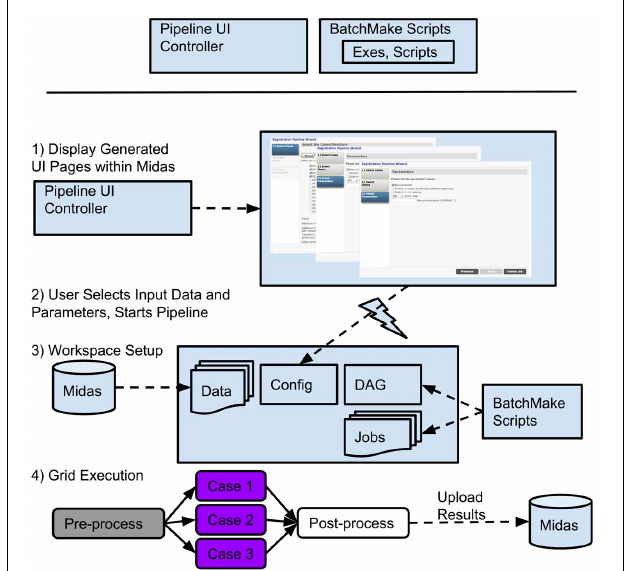
FIGURE 11 | Pipeline development and